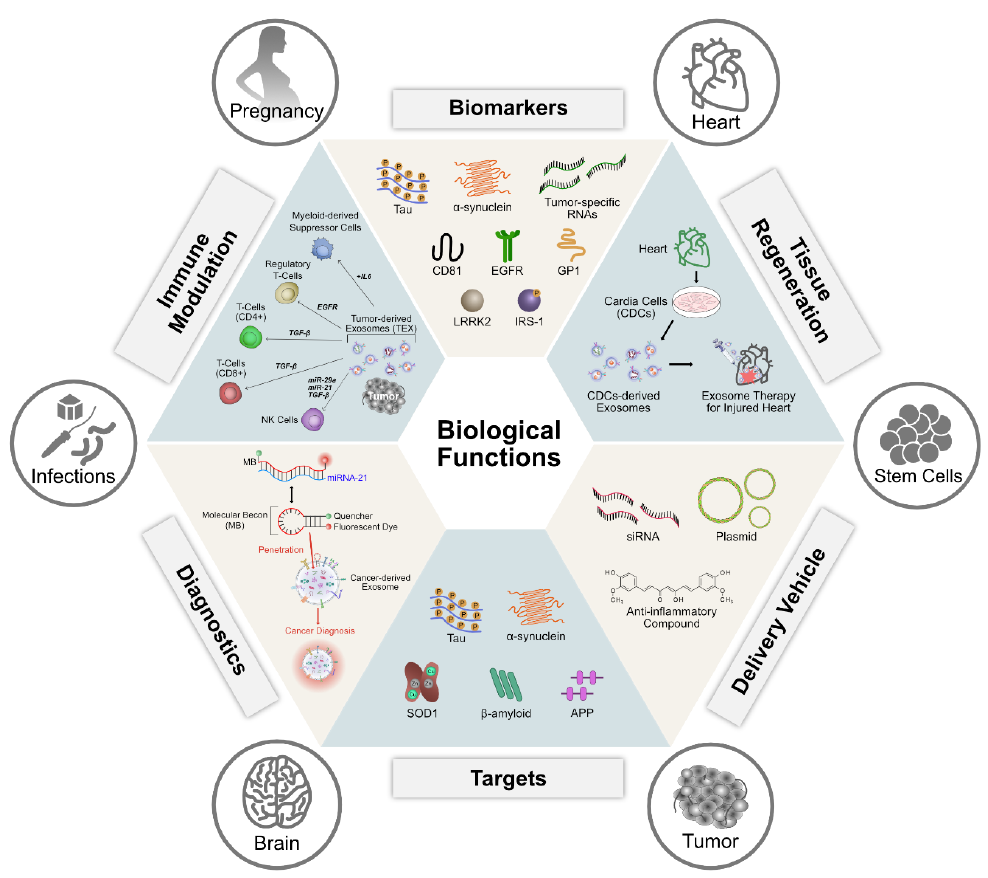
Figure 6. Biological function of exosomes.